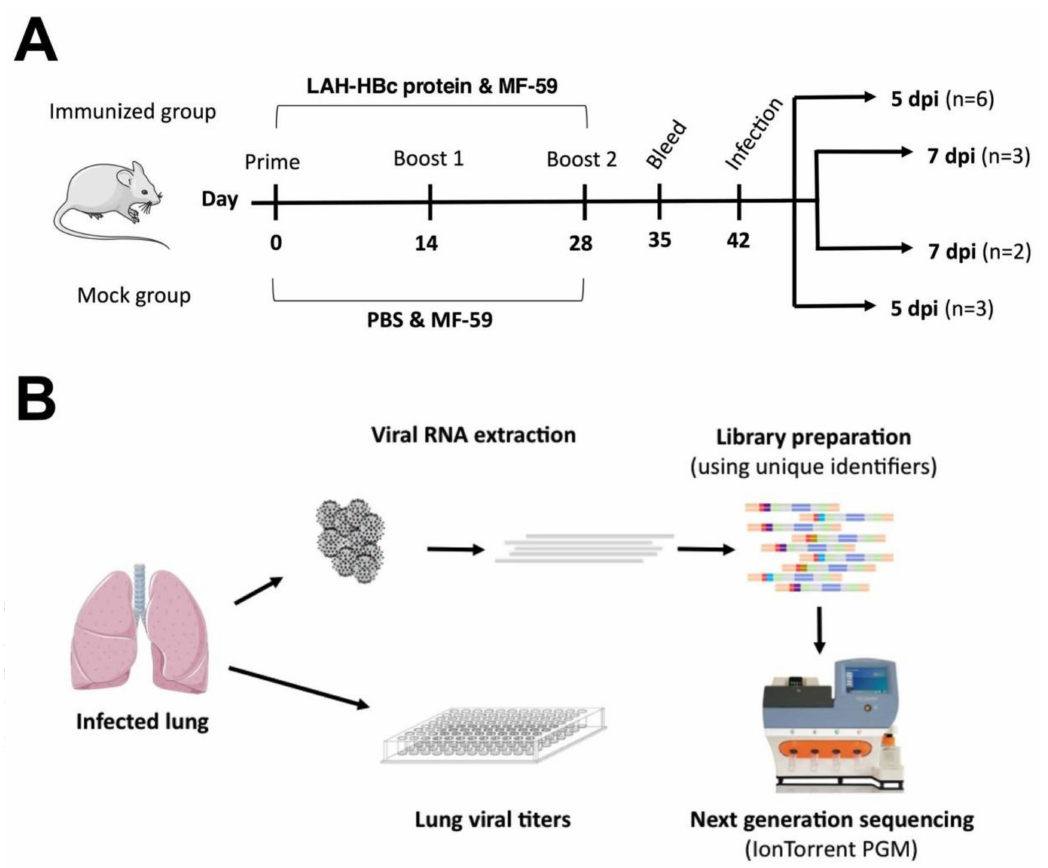
Figure 1. ( A ) Scheme of mouse immunization and virus challenge. ( B ) Assays performed on lung samples from immunized and mock immunized